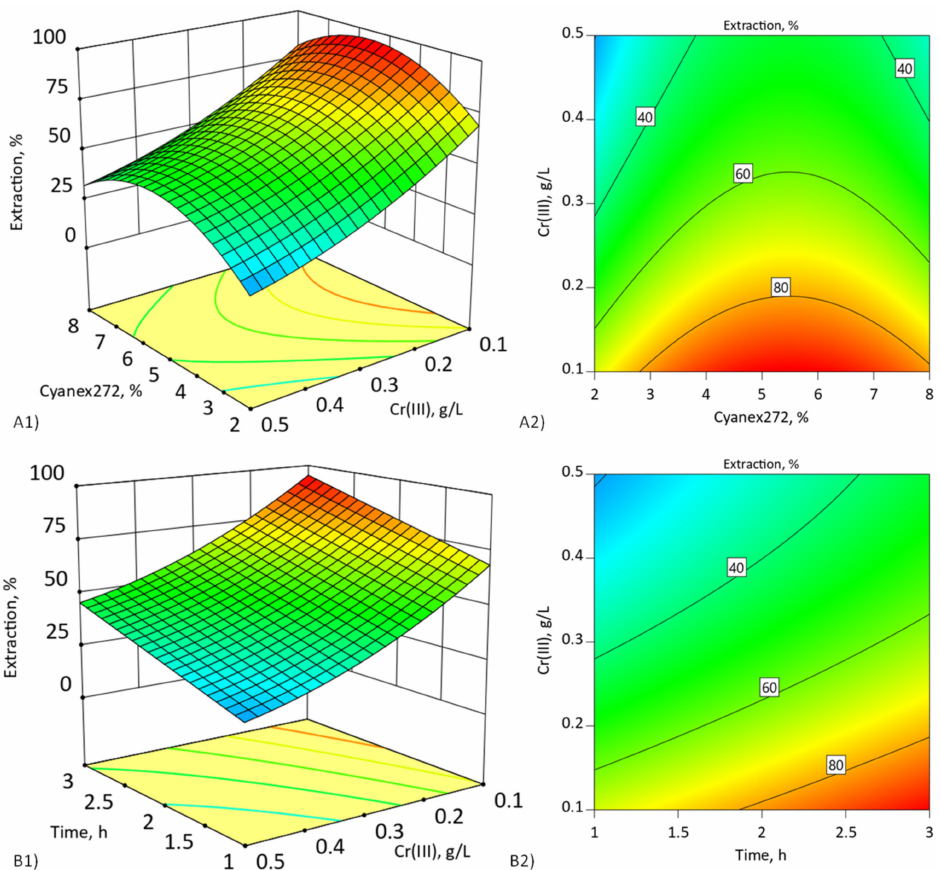
Figure 4. ( A1 , A2 ) Three-dimensional surface plot and contour plot of concentration of Cyanex272% ( v / v ) and chromium(III) (g/L) after 3 h extraction; ( B1 , B2 ) extraction time (h) and chromium(III) (g/L) for 5% v / v Cyanex272. DCSLM with threshold concentration of D2EHPA.